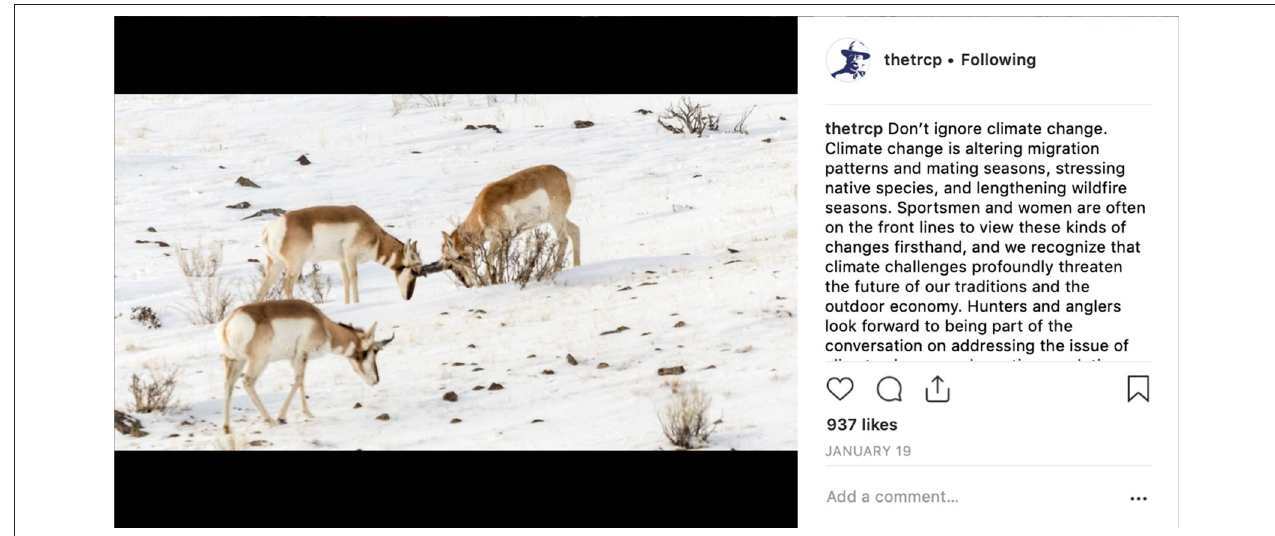
FIGURE 1 | Instagram post by the Theodore Roosevelt Conservation Partnership (https://www.instagram.com/p/Bs08_QXDPIb/; used with permission).